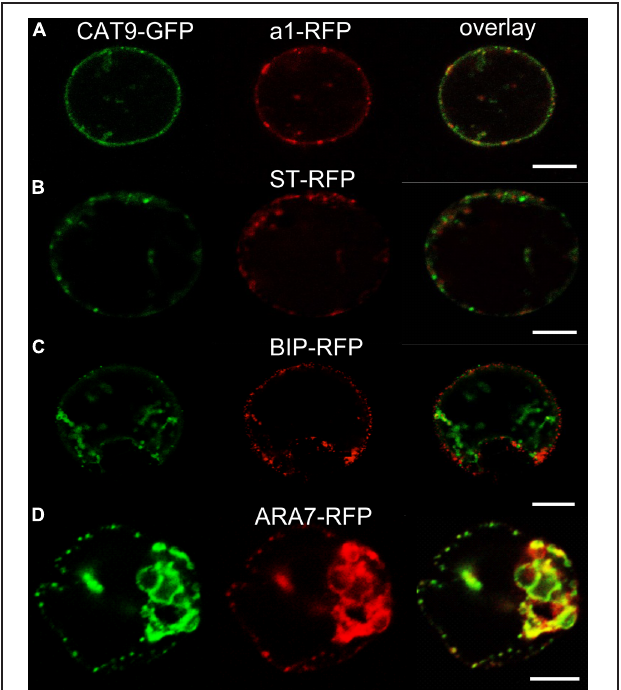
FIGURE 2 | Sub-cellular co-localization of pCAT9:: CAT9–GFP (green, left) with red fluorescent protein (mRFP) -labeled markers (red, middle) and overlap (right) in transiently expressing protoplasts. (A) Trans -Golgi network (TGN) marker V-ATPase subunit a1-RFP, (B) Golgi